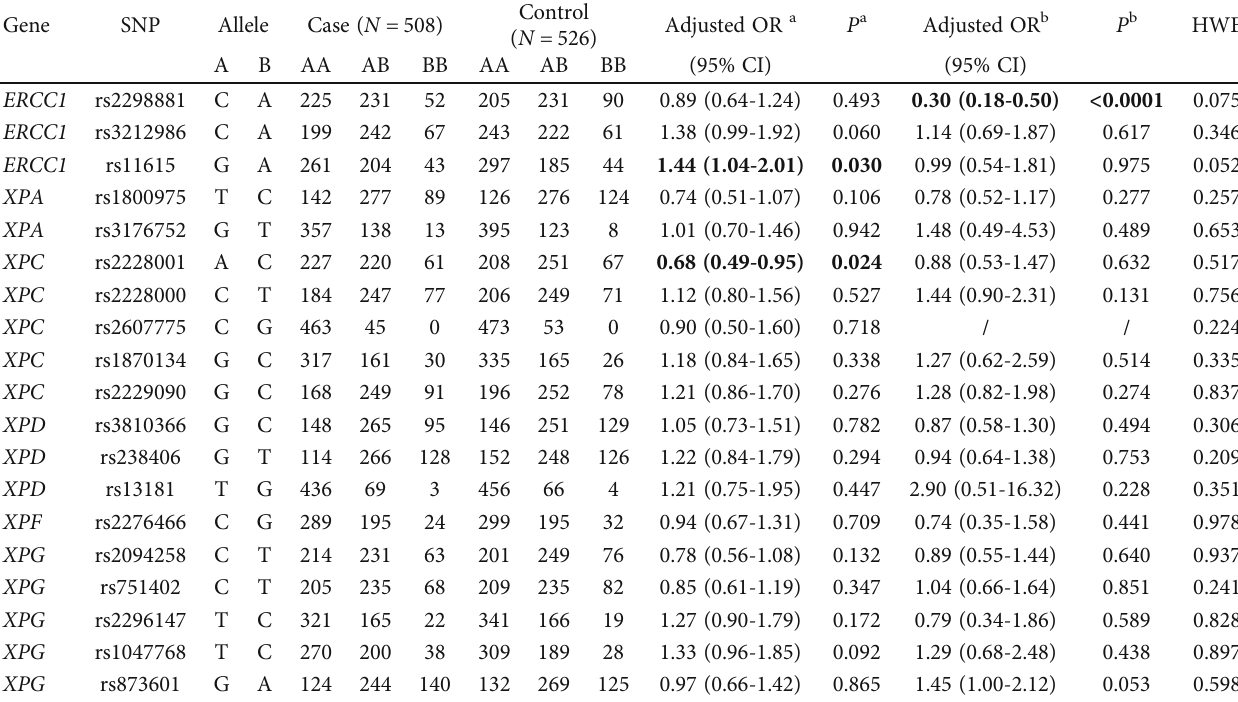
Table 1: Association between polymorphisms in nucleotide excision repair pathway genes and allergic rhinitis susceptibility. Gene SNP